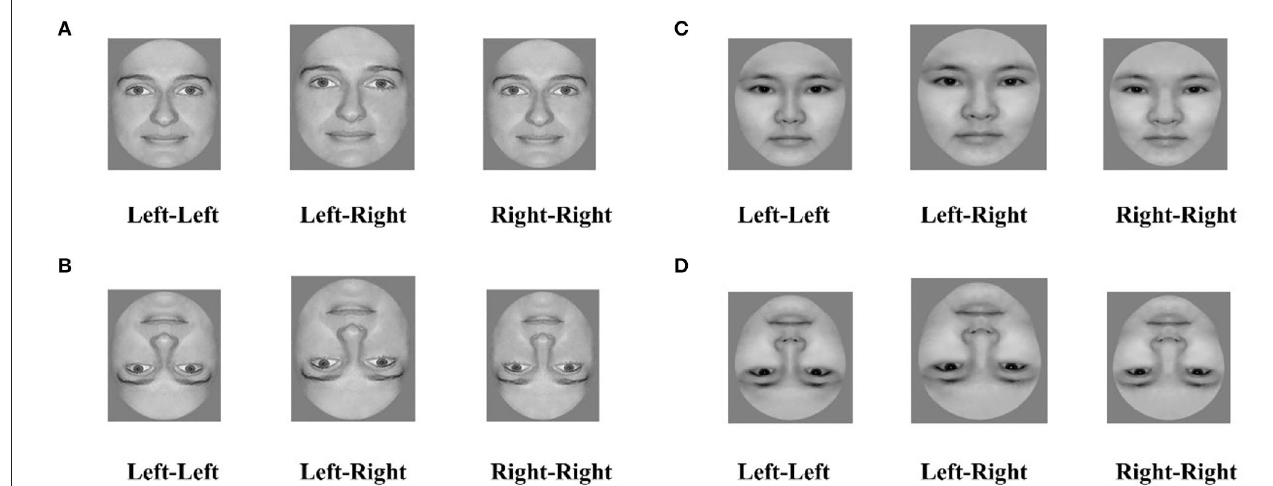
FIGURE 1 | Examples of face stimuli: a “Left-Left;” Chimera made from the left-face half; the “Left-Right” original face; and a “Right-Right” chimera made from the right face half. The faces above are as follows: (A) upright Caucasian, (B) inverted Caucasian, (C) upright Chinese, (D) inverted Chinese. All individuals whose face images were used permitted us to use their photographs in academic